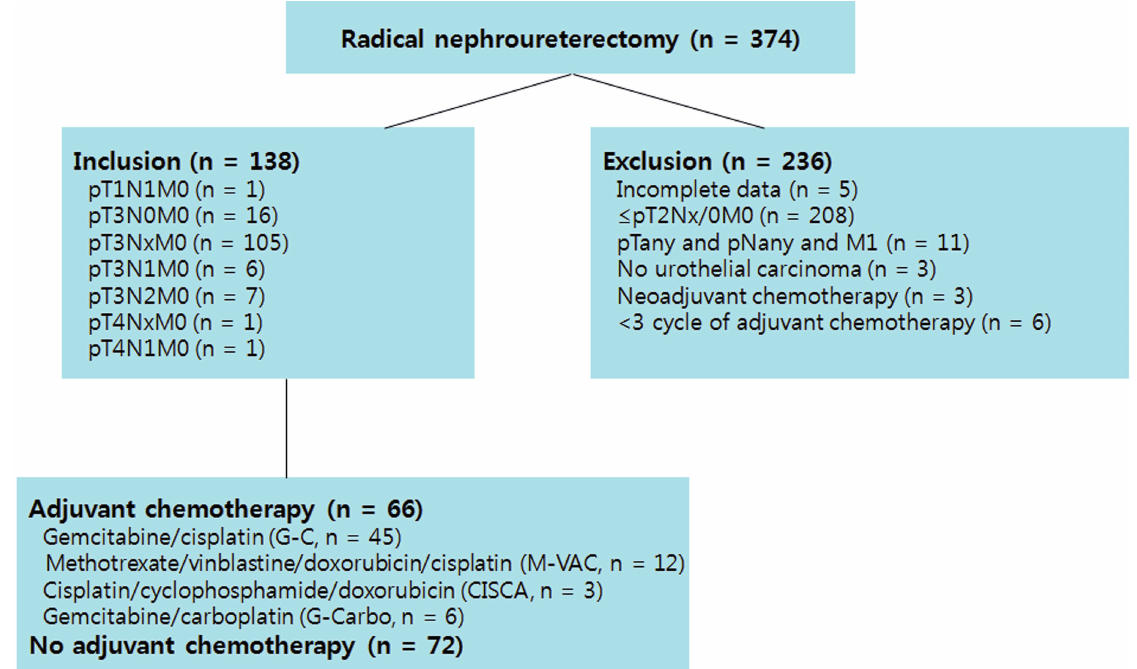
figure 1 - study flow